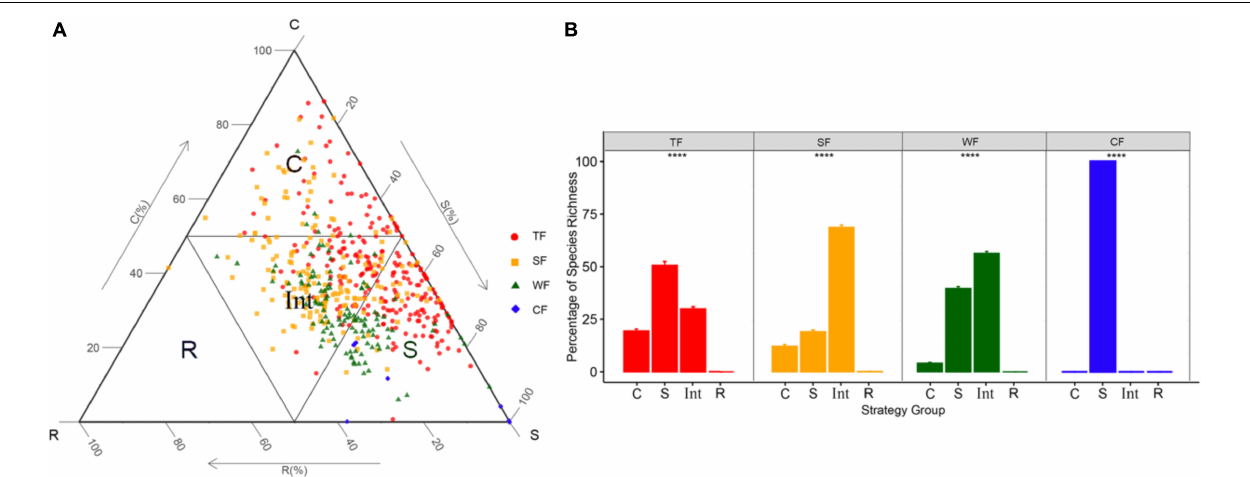
FIGURE 1 | (A) The distribution of tree and shrub species ( n = 536) and the delimitation of the four ecological strategy groups in the CSR triangle. (B) Bar plots showing species’ percentage of each ecological strategy group of ecological strategy spectrum of four forest types. **** P < 0.001 means significant difference among ecological strategy groups. Different symbols indicate species in different forest types: TF, tropical forest (red circles); SF, subtropical forest (yellow squares); WF, warm-temperate forest (green triangles); and CF, cold-temperate forest (blue diamonds). Ecological strategy group abbreviations are as follows: C, competitors; S, stress-tolerators; R, ruderals; Int, Int-strategists. Different colors indicate different forest